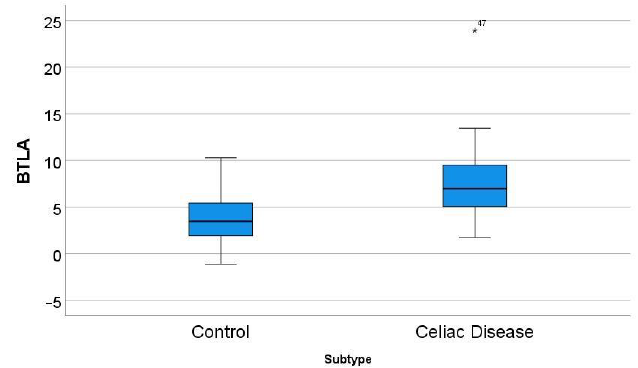
Figure 5. Differential gene expression of BTLA between celiac disease and control in the series GSE164883. A direct comparison was statistically significant: 7.8 ± 4.4 vs. 3.7 ± 2.8 ( p < 0.001). The icon “*” corresponds to a far outlier, and the number “47” is the case number (i.e. the BTLA expression value for case 47 was 23.94).